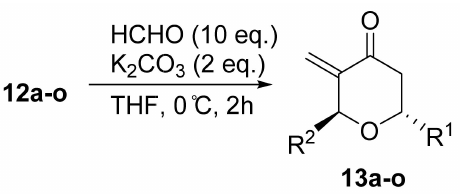
Scheme 4. Synthesis of trans -2,6-disubstituted 3-methylidenetetrahydropyran-4-ones trans - 13a–o